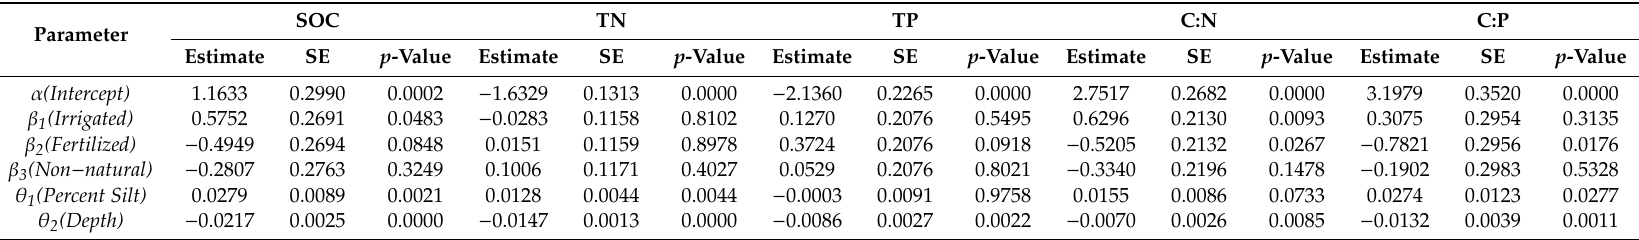
Table 2. Estimates and regression using the mixed e ff ect model for soil organic carbon (SOC), total nitrogen (TN), total phosphorus (TP), and carbon to nitrogen ratio (C:N) and carbon to phosphorus ratio (C:P) ratios.